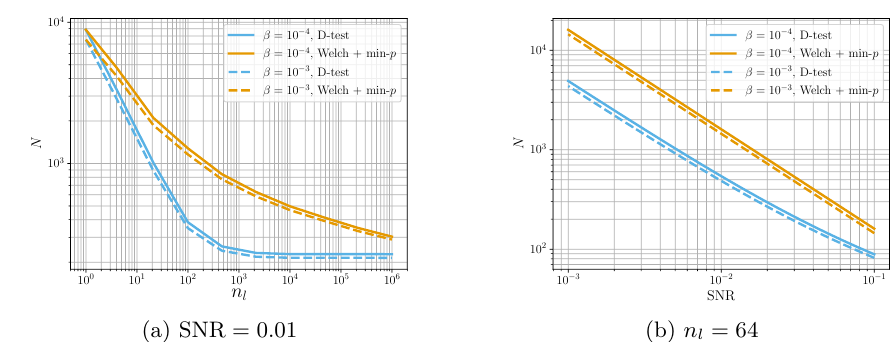
Figure 5: Number of traces N required to detect for a fixed false negative rate β on simulated traces with a density of φ = 1, and varying trace length n l and SNR.